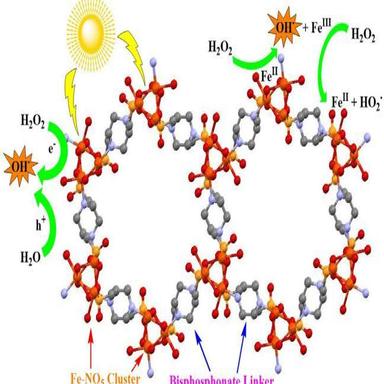
Proposed mechanism for the Fenton and photo-Fenton activation of H2O2 by STA-12(Fe) under natural sunlight irradiation.